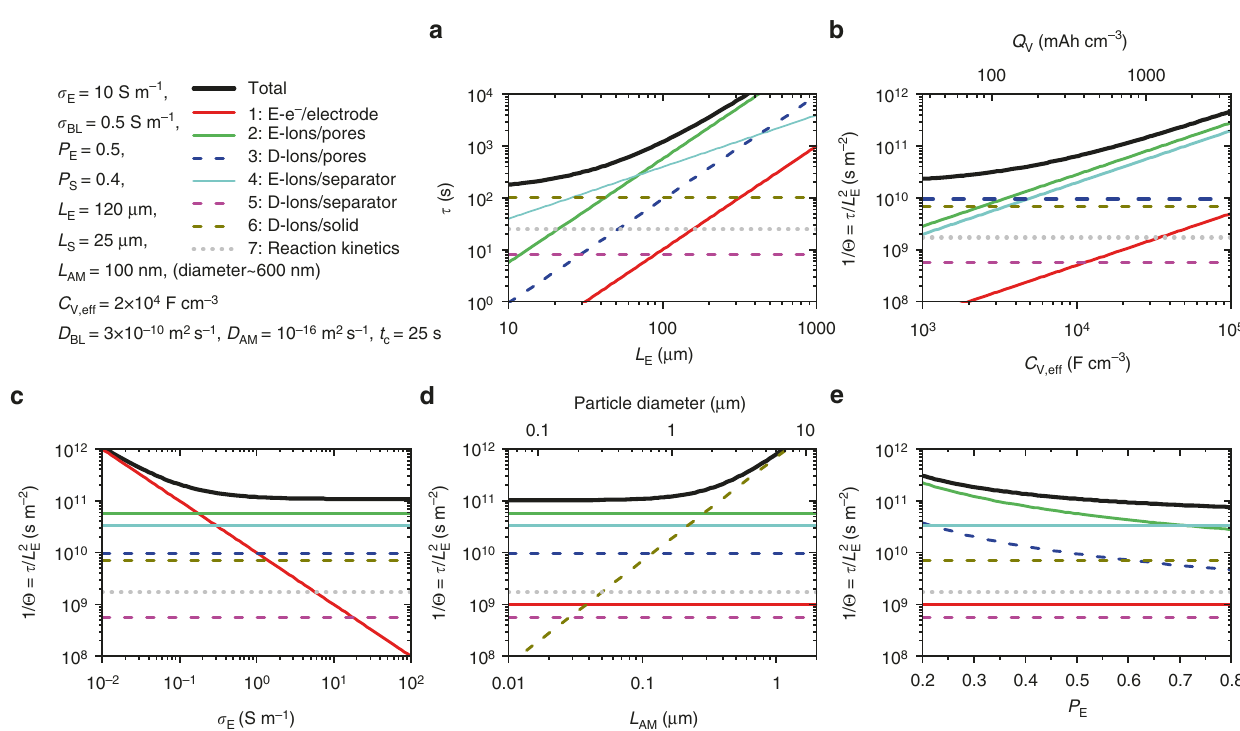
Fig. 6 Comparison of the magnitude of terms 1 − 7 in Eq. (13a) as well as their sum, for a range of electrode parameters. Note that, while in a , τ is plotted versus L E , in all other panels, 1/ Θ is plotted versus the relevant parameter. The parameters used are given at the top left. Those bold parameters were kept constant in all panels except one, where they were varied. The solid black lines represent the total value of τ or 1/ Θ . Low values of both τ and 1/ Θ are needed for good rate performance. The other curves represent the seven individual terms in Eq. (13a), labelled 1 − 7 (numbered from left to right in the equation). Electrical and diffusion limited terms are marked as solid and dashed lines, respectively, with the reaction kinetics term represented by grey dots. The legend in the top left gives the term number as well of a summary of what it represents. Those terms labelled by “ E ” are electrically limited while those = Q ¼ 28 F = mAh . N.B., L labelled by “ D ” are diffusion limited. The top axis in b represents the volumetric capacity of the electrode calculated using C AM V ; eff V = 100 nm corresponds to a particle diameter of 2 r ≈ 600 nm because L = r /3 for pseudo-spherical AM